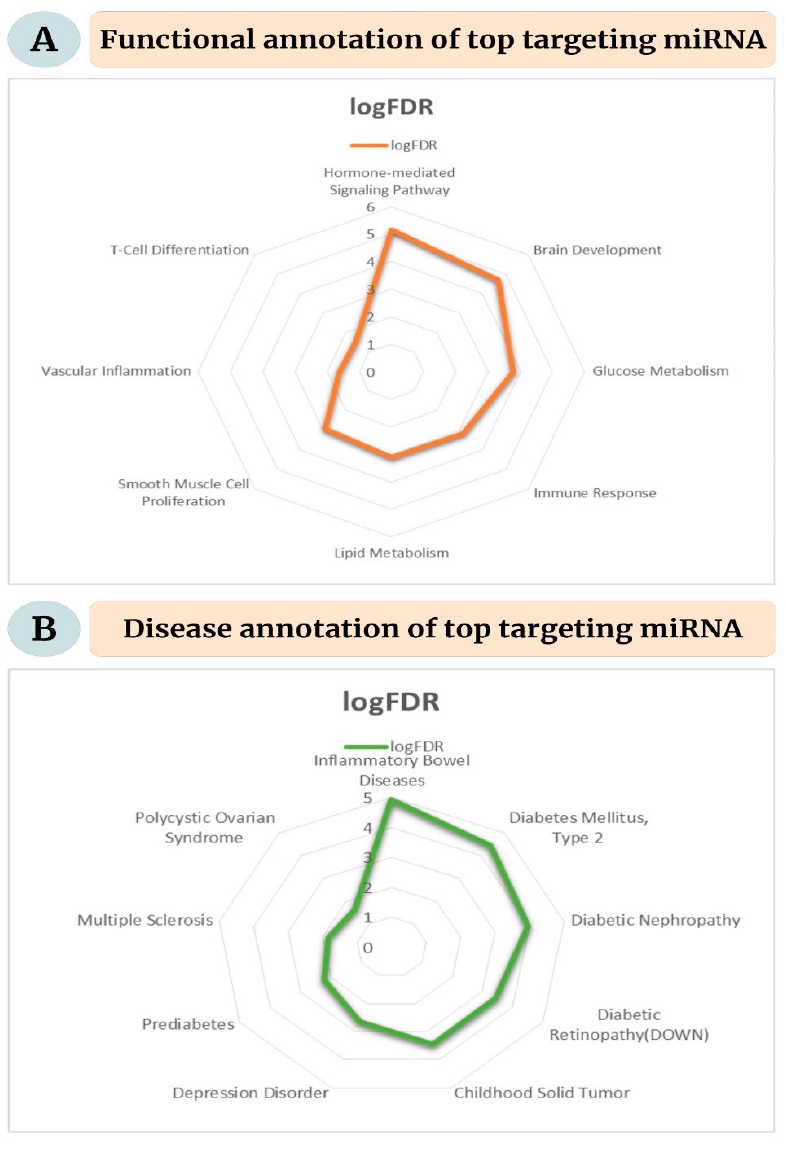
Figure 8. Functional enrichment for the top targeting miRNA. ( A ) Significant functional annotations for the miRNA, ( B ) significant disease associations for the selected miRNA.